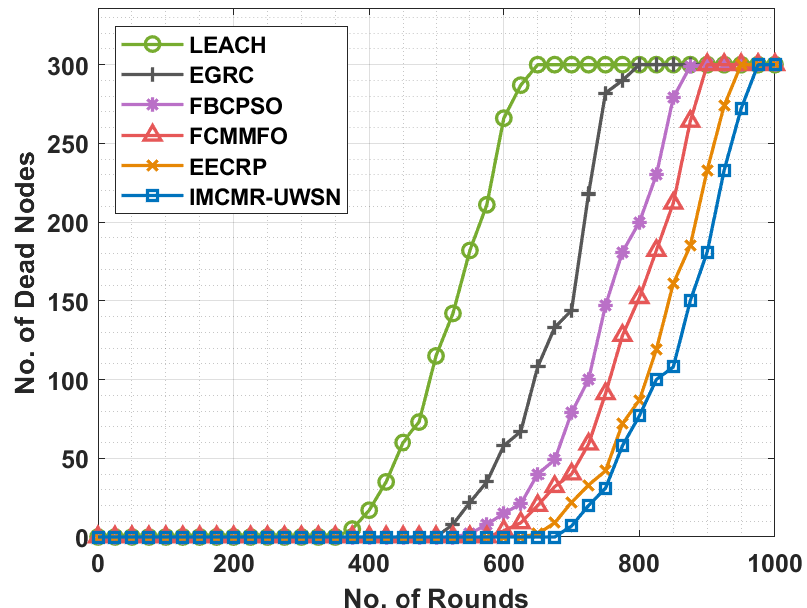
Figure 4. NDN analysis of the IMCMR-UWSN technique.